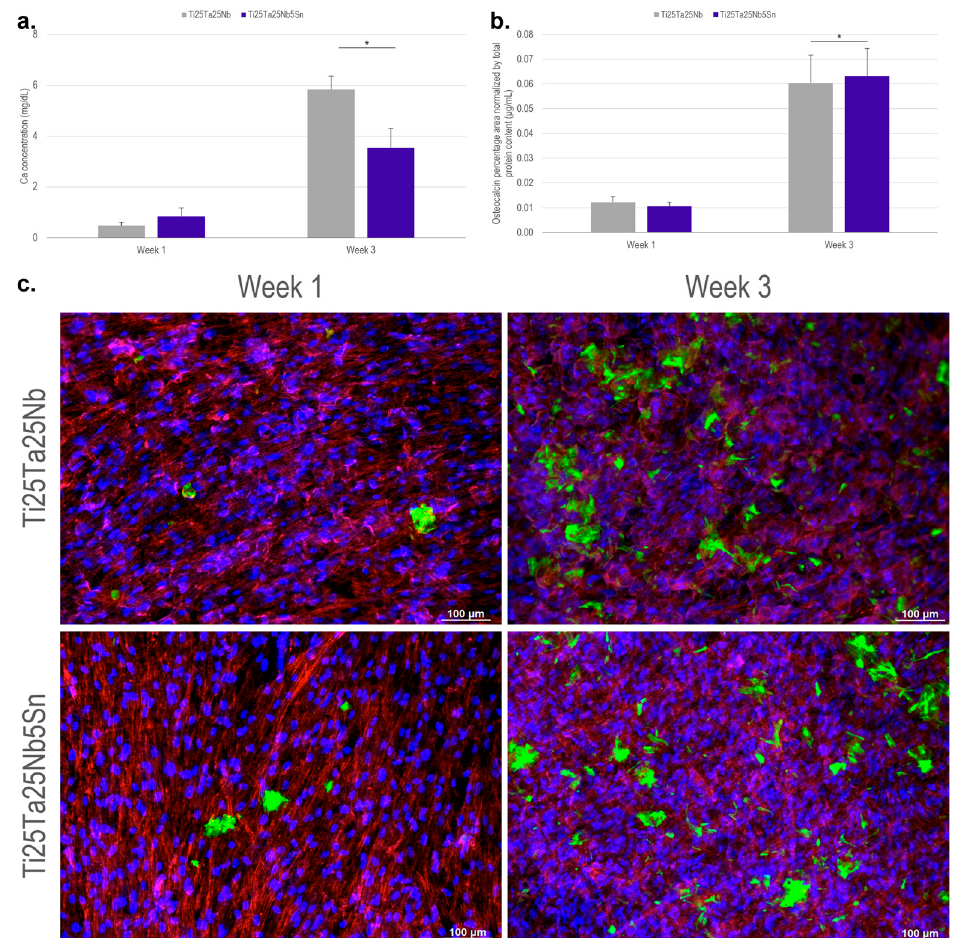
Figure 6. Evaluation of cell differentiation on the surface of Ti-25Ta-25Nb and Ti-25Ta-25Nb-5Sn alloys. ( a ) Ca deposited on the surfaces, ( b ) percentage area coverage by osteocalcin normalized by total protein content, and ( c ) immunofluorescence microscopy images of ADSCs after 1 and 3 weeks of induced osteogenesis. Osteocalcin is represented in green. (*) Represents the significant difference between groups, with p < 0.01.